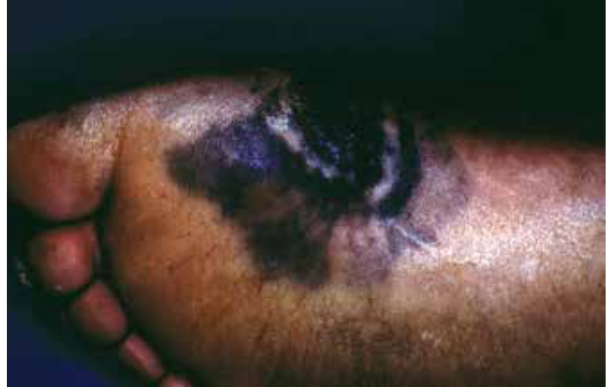
Figure 12: Acral lentigenous melanoma on the sole of